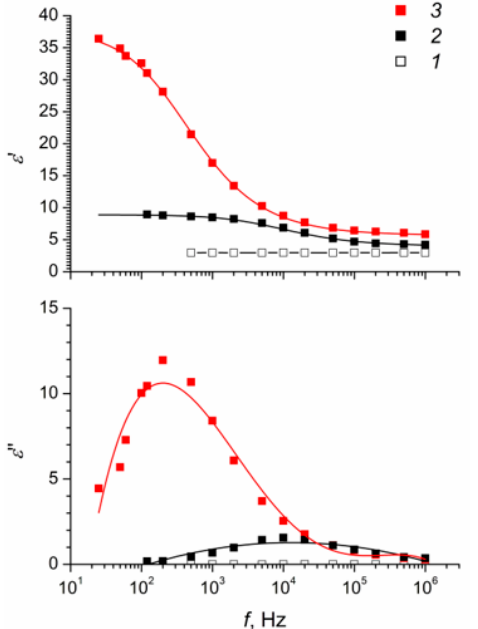
Figure 5. The dielectric constants ( ε ′ , ε ′′ ) as functions of frequency for (1) unmodified polydimethylsiloxane and TiO 2 -modified polydimethylsiloxane samples: (2) ERE-0; (3) ERE-5.